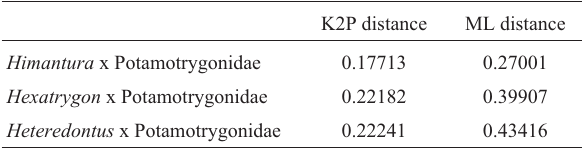
Table 3 - Distances among outgroup taxa and an average of PotamotrygonidaespeciesunderK2PandGTR+invmodelofevolution.